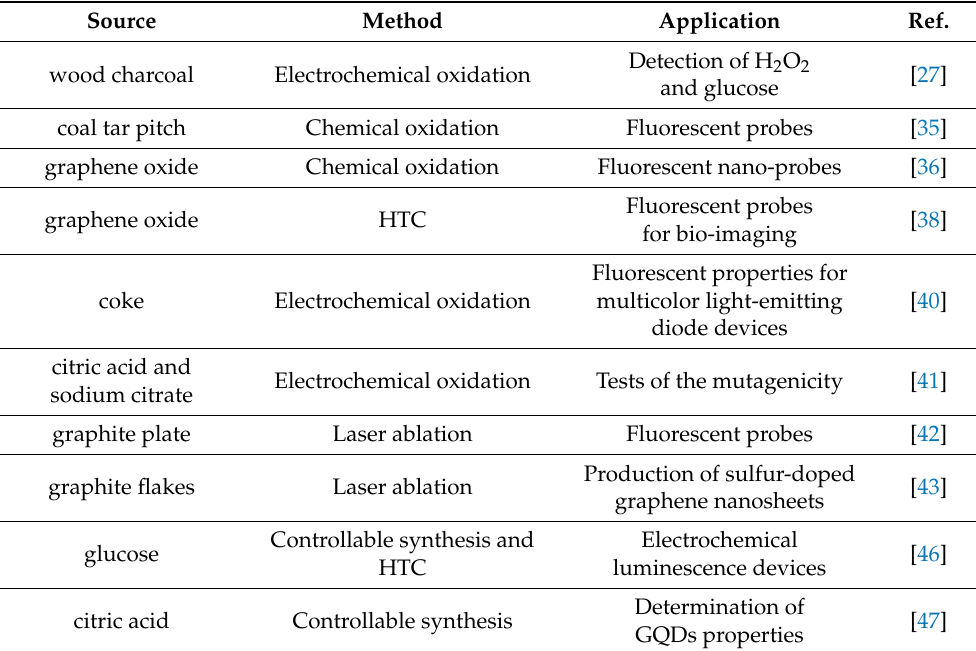
Figure 2. Four green approaches adopted to prepare GQDs. ( a ) Illustration of the preparative strategy for N-GQDs by electrochemical exfoliation and RGOQDs from GO with Hummers method. (Adapted with the permission of Ref. [46]). ( b ) Synthetic one-step process for the production of SL/GQDs used as sensing platform for Fe3+ detection by Xu et al. (Adapted with the permission of Ref. [64]). ( c ) The hydrothermal strategy for the functionalization of GQDs synthetized from glucose. ( d ) Schematic representation of the nucleation and growth of GQDs obtained from citric acid. Table 1. GQDs synthesized from different natural sources through green approaches by several techniques and their